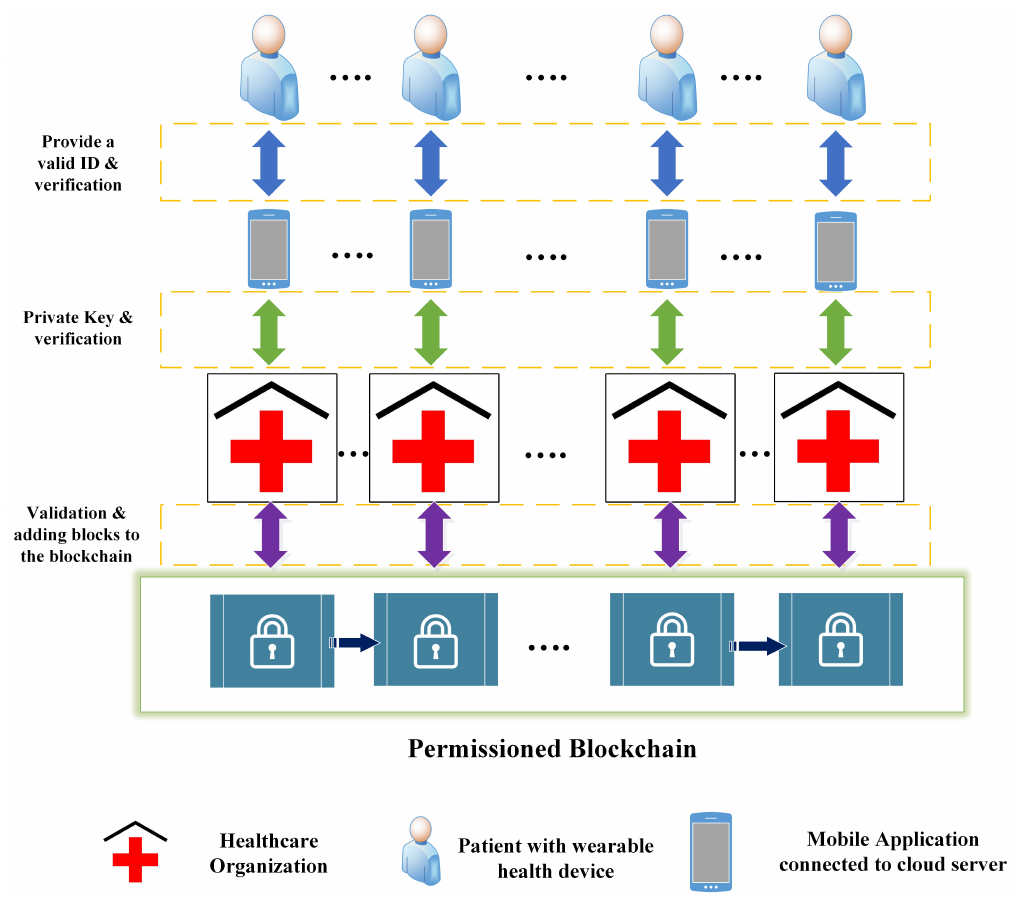
Figure 6. Blockchain network of the proposed